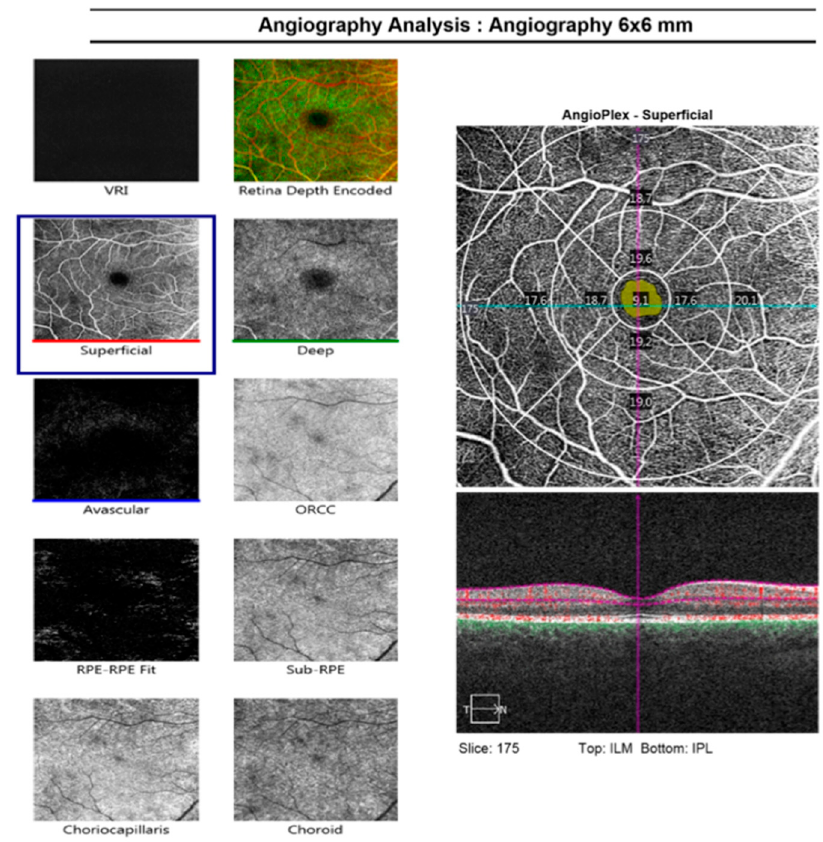
Figure 1. Sample OCT angiography of a previously amblyopic eye that had been treated by patching. Legend for macular regions mentioned in the main text is illustrated in the bottom right of the image.